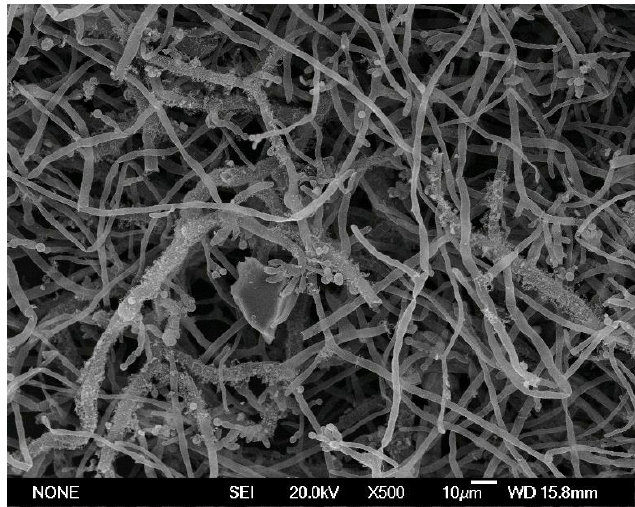
Figure 4. SEM image of the fungus Aspergillus niger grown on fluorescent lamp powder (1% pulp density) during bioleaching experiments.